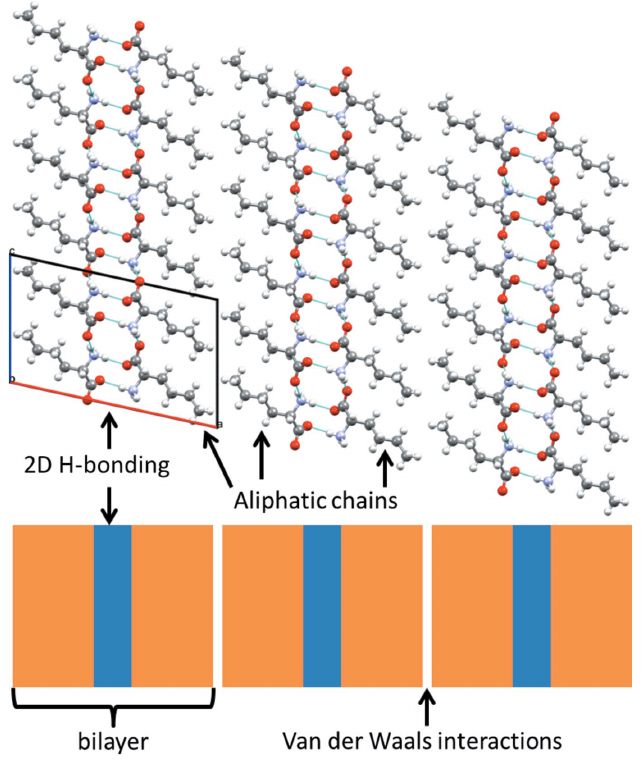
Figure 3 Schematic of the typical crystal structure of the racemic aliphatic linear- chain amino acids; dl -Nle is used as an